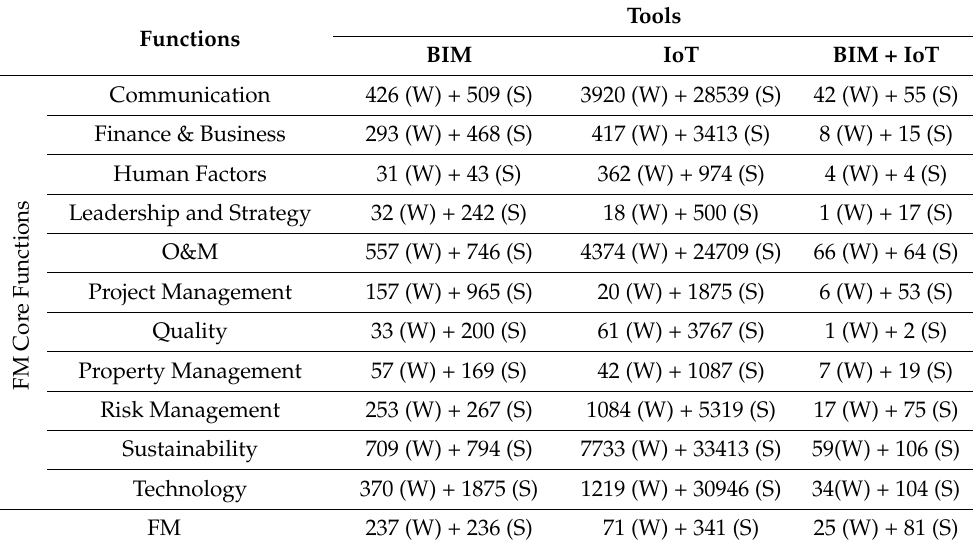
Table 4. Journals’ articles on BIM, IoT and their integration for FM and its core functions from WoS (W) and Scopus (S) databases (until February